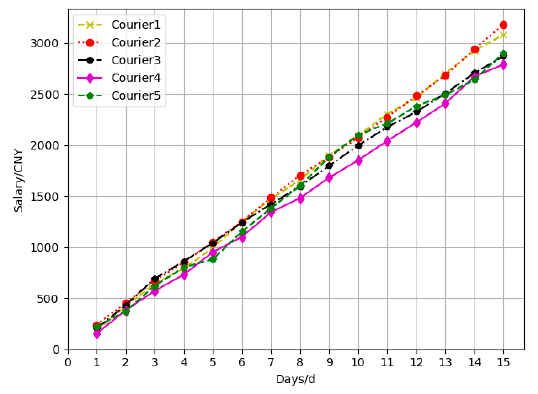
Figure 7. Cumulative Salary chart.